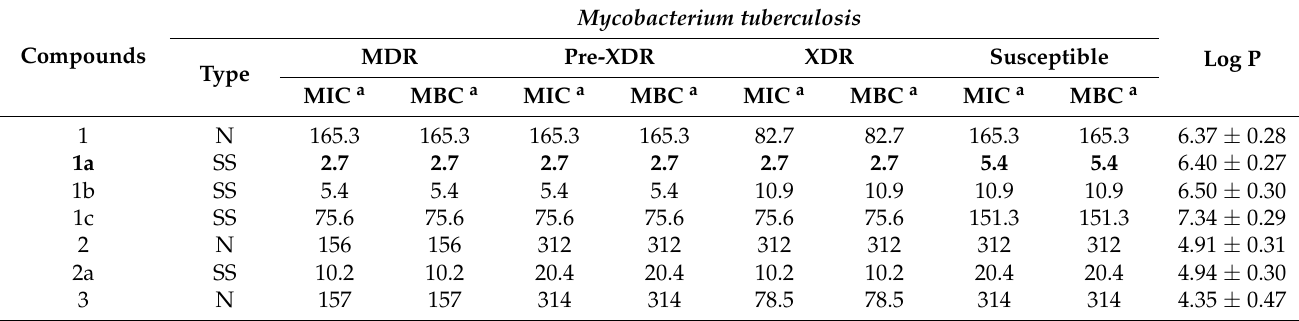
Table 1. In Vitro antituberculosis activity and lipophilicity of natural and semi-synthetic mulinanes.